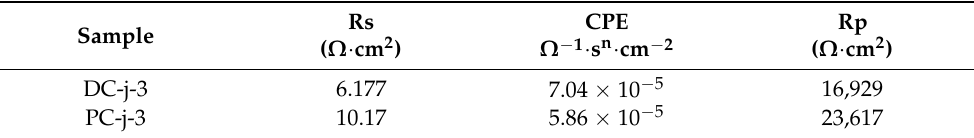
Figure 9. Tafel polarization curves ( a ) and Nyquist plot ( b ) of the Ni-Co/WS 2 nanocomposite coatings prepared with different electrodeposition methods. Table 7. The equivalent electrical circuit parameters obtained by fitting the EIS of the coatings prepared with different electrodeposition